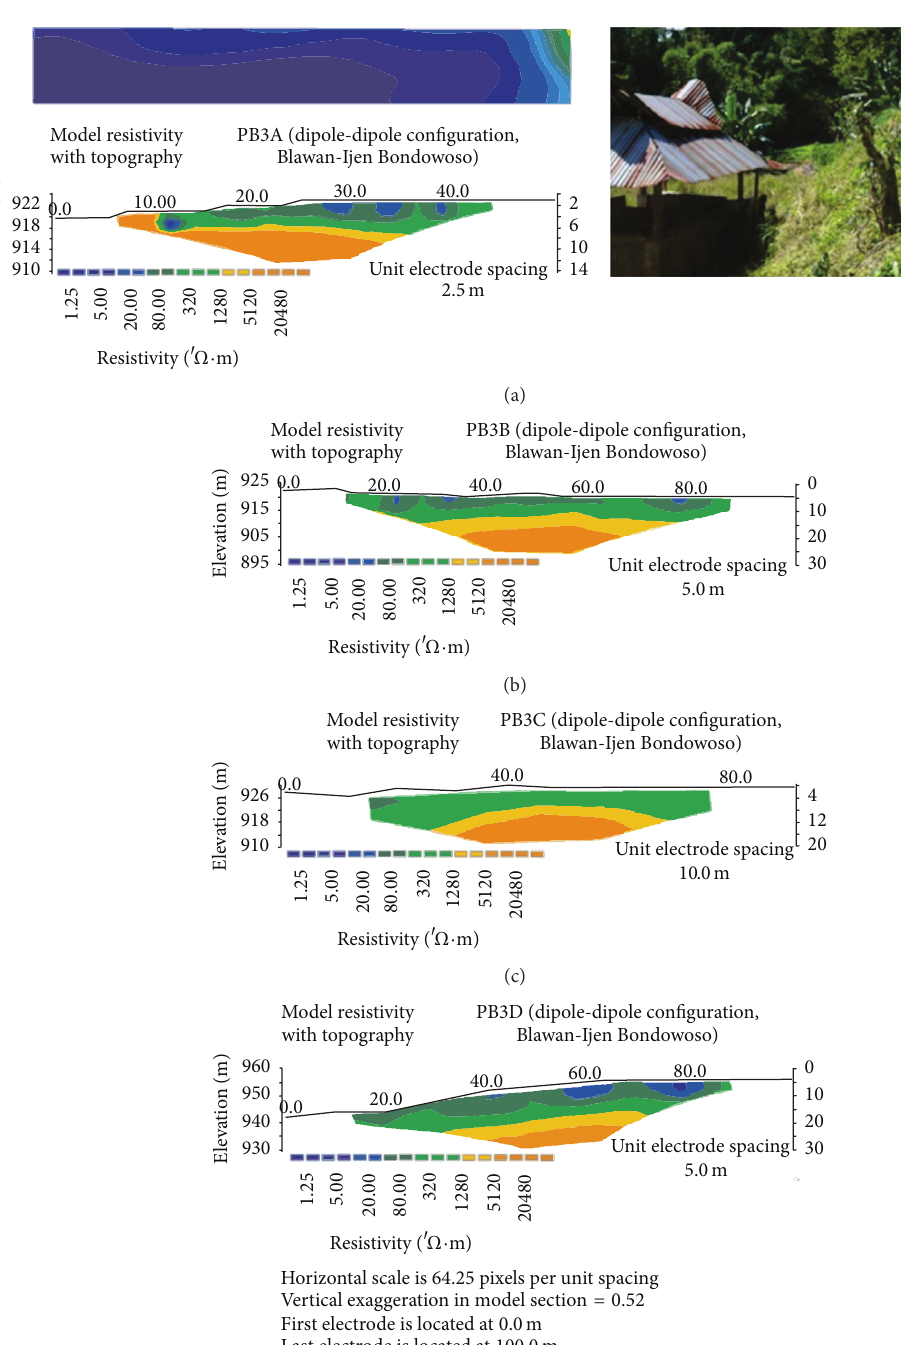
150 m and the depth range of the anomalies reaches up to 25 m. The hot water flow shown in blue layer ( < 40 Ω m) in PB4A line (Figure 8(a)) is present along 21 m-22 m of hori- zontal profile and extends down up to 5 m of depth under the surface. While, in PB4C line (Figure 8(b)), the hot water is present along 22 m–24 m, 32 m–34 m, 115 m–120 m, and